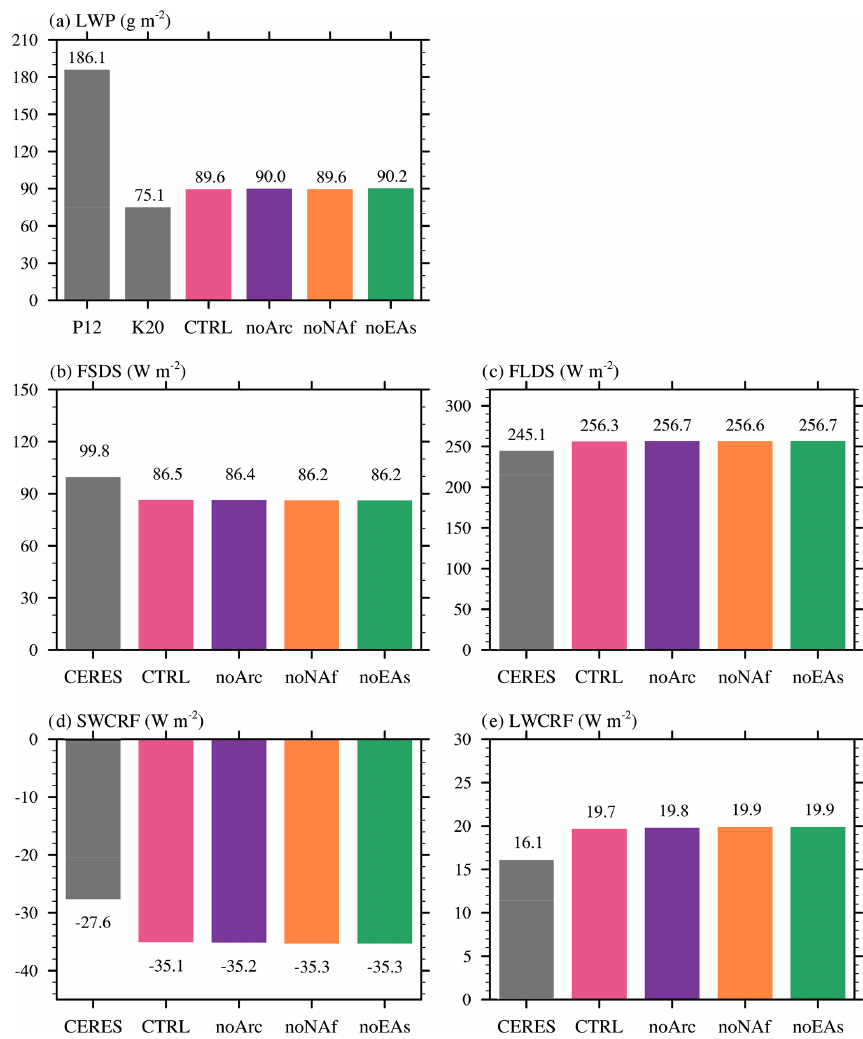
Figure 14. (a) Annual mean Arctic (60 to 80 ◦ N here) averaged LWP over ocean for the MODIS observations and the four simulations (2007–2008). Two MODIS datasets are used, including the standard product (Pincus et al., 2012, P12; averaged from 2007 to 2008) and an improved one (Khanal et al., 2020, K20; averaged from 2007 to 2009). The MODIS simulator is used to calculate the simulated LWP. (b– e) Annual mean Arctic (60 to 90 ◦ N in these panels) averaged (b) FSDS, (c) FLDS, (d) SWCRF, and (e) LWCRF for the CERES observation (2007–2011) and the four simulations